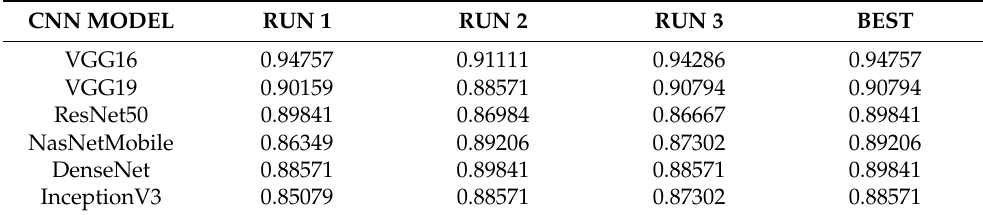
Table 4. Summary result of the preliminary test runs for the different CNN models.